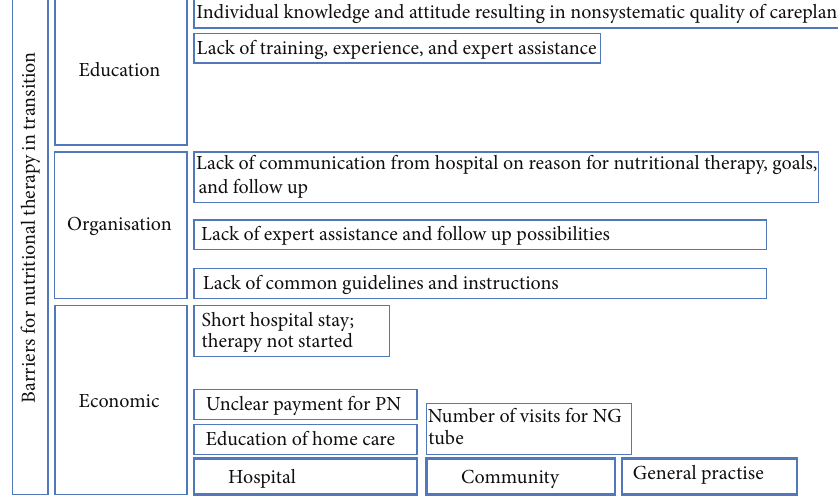
Figure 2: Barriers for nutritional therapy in the transition between hospital and